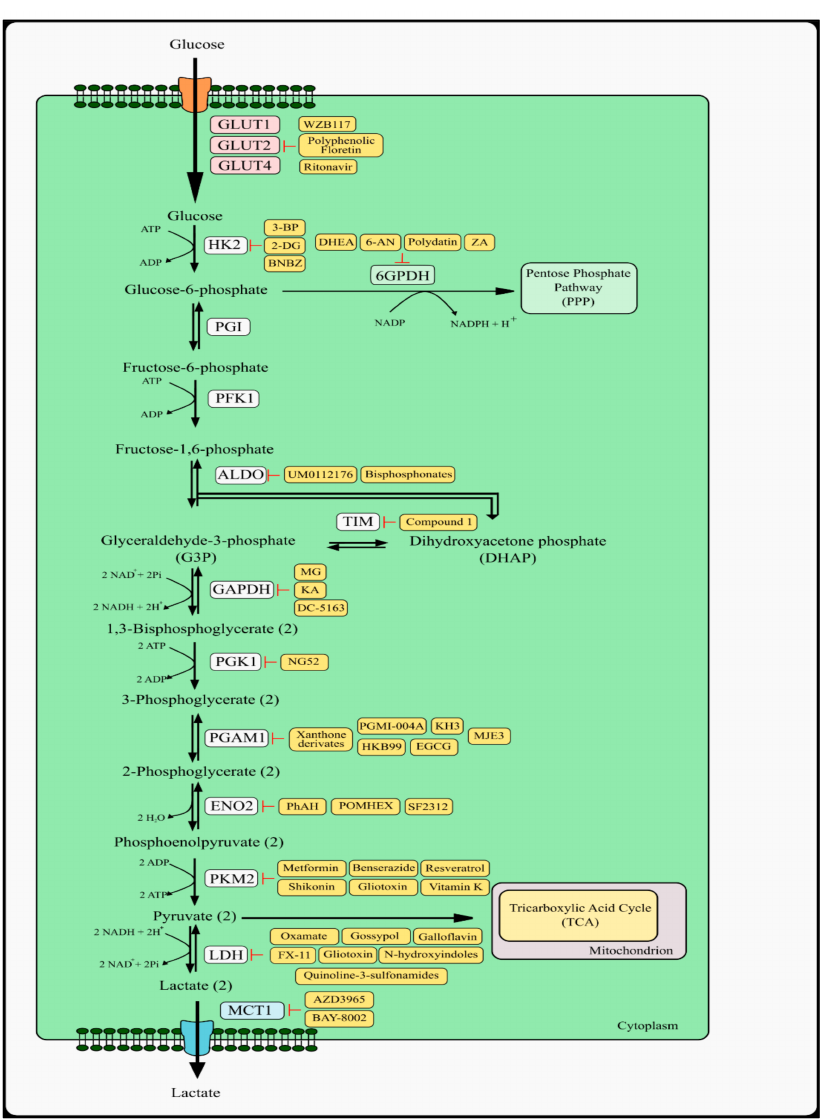
Figure 1. Graphical representation of inhibitors of glucose transport, glycolysis pathway, 6GPDH, and its metabolic